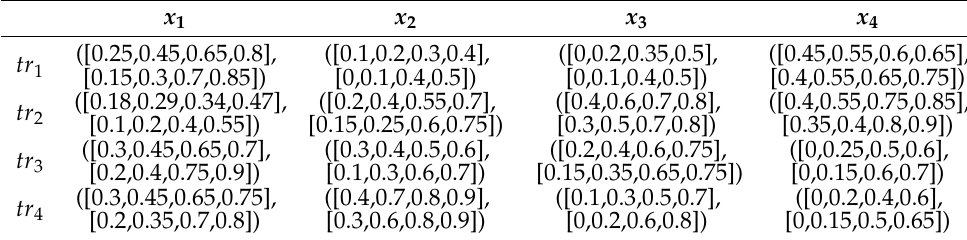
Table 3. Expert r 3 ’s decision matrix ˜ D 3